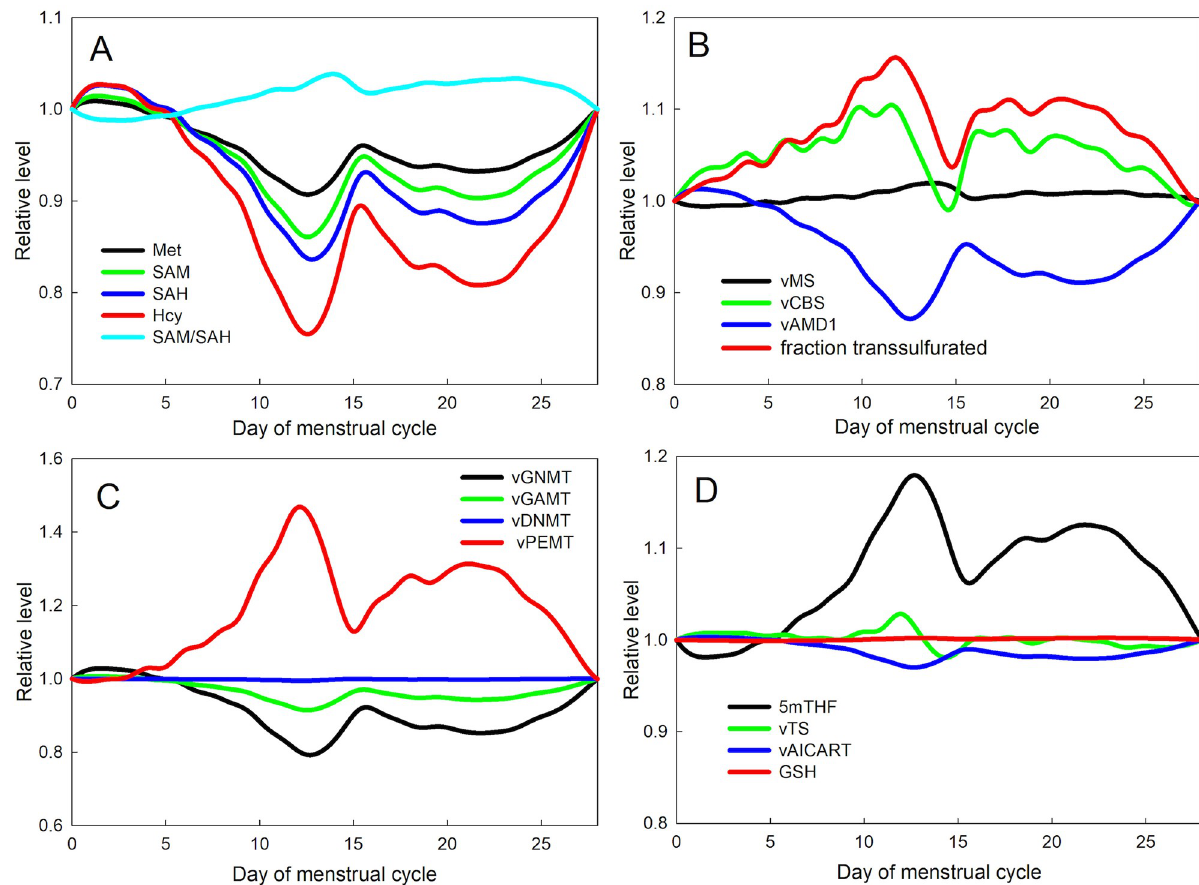
Fig 3. One-carbon metabolism during the menstrual cycle. Panel A shows the model concentrations of Met, SAM, SAH, and Hcy and the SAM/SAH ratio throughout the menstrual cycle, relative to their values at the beginning of the cycle. Panel B shows the model velocities of the MS, CBS, and AMD1 reactions, and the fraction of flux arriving from SAH that is transsulfurated. Panel C shows the model velocities of four important methyltransferases, GNMT, GAMT, DNMT, and PEMT. Finally, Panel D shows the relative model concentrations of 5mTHF and GSH, and the velocities of the TS and AICART